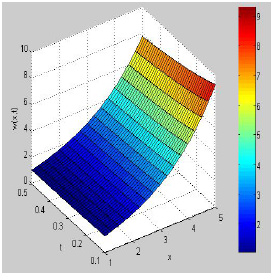
Fig. 6: Surface graph of w ( x , t ) of eq. (8.4), when α = 0.6